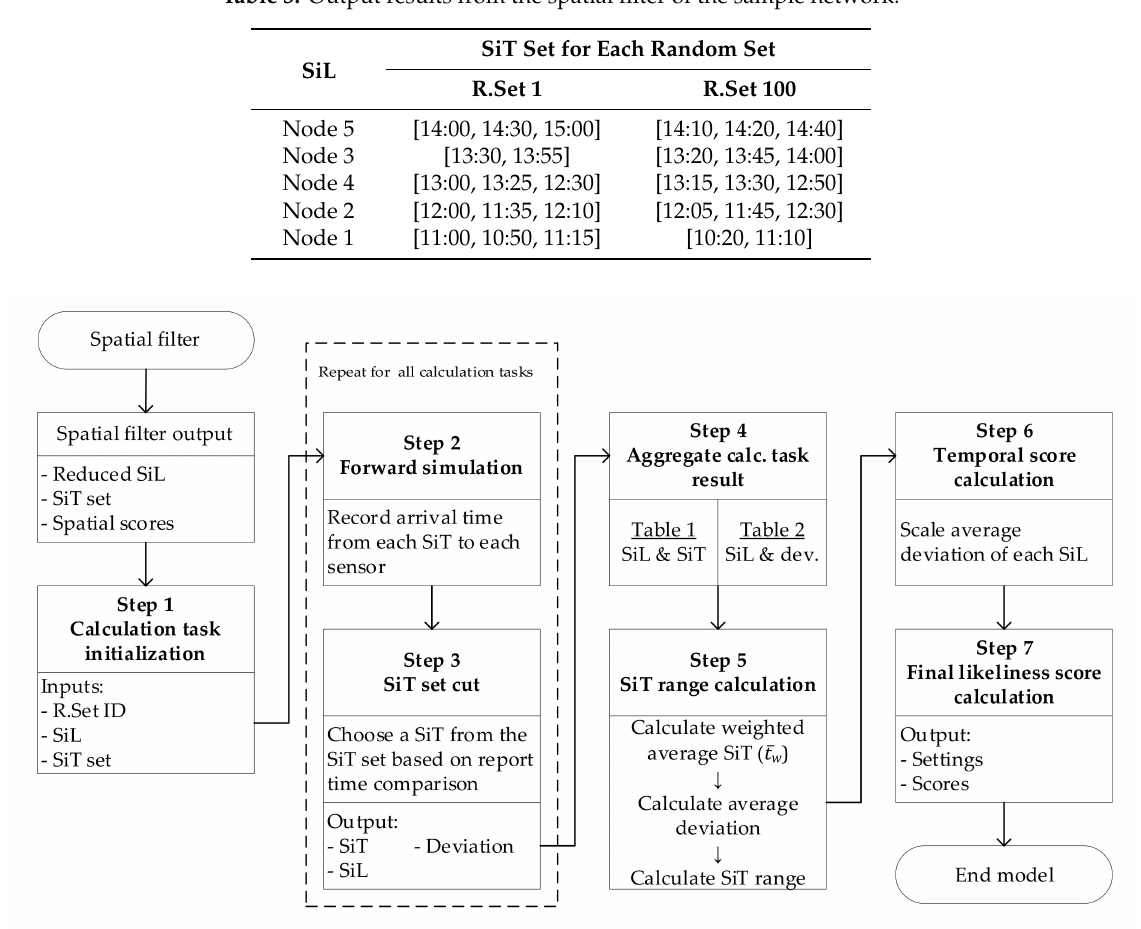
Figure 6. Calculation flowchart of the temporal